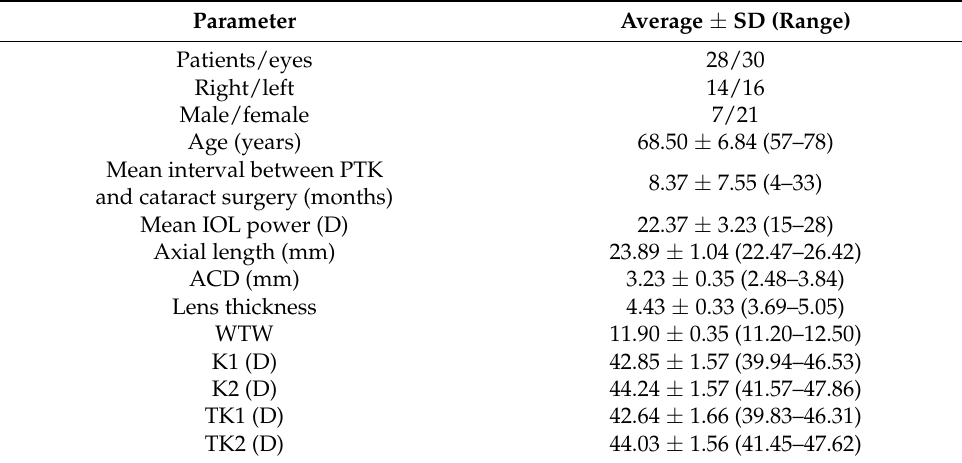
Table 1. Patient characteristics and preoperative biometry.